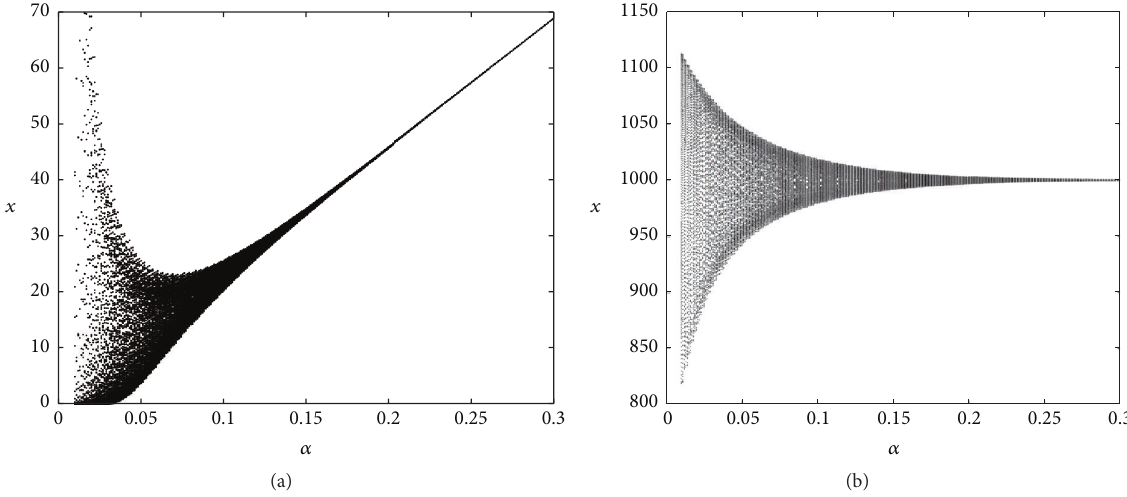
Figure 11: Diagram of bifurcation of the equilibrium points with respect to 𝑥 (a) and 𝑦 (b), for the parameter 𝛼 varying from 0 to 0.3, = 100.1 , 𝑦 = 𝑠 = 1230 for 𝐴 = 1 , 𝑇 = 1000 , and 𝑘 = 𝑥 1 1